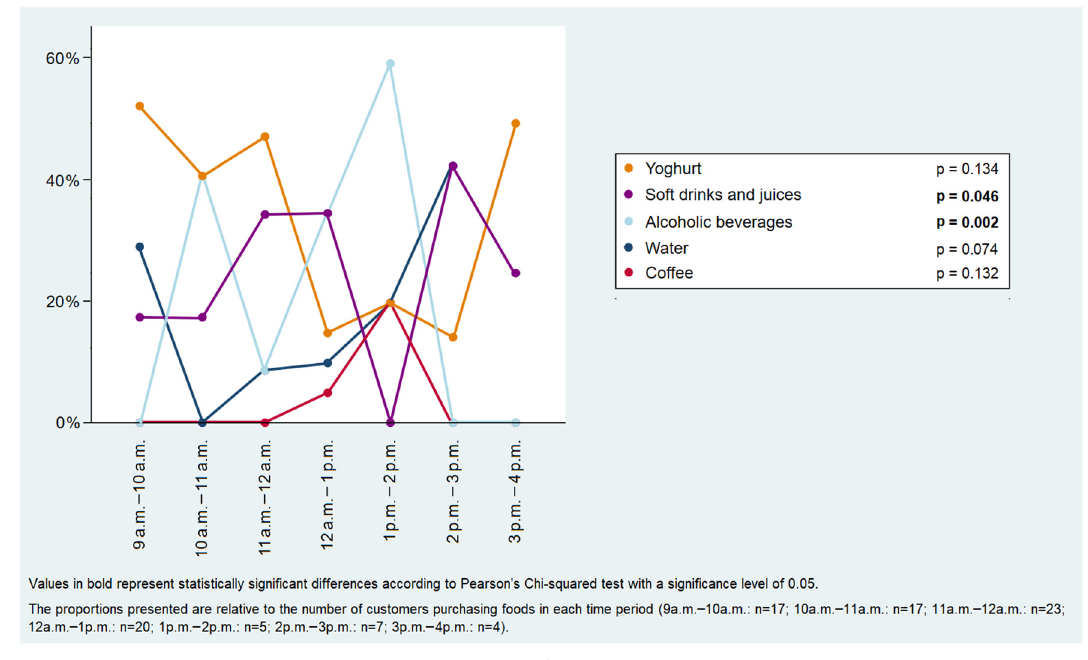
Figure 5. Distribution of the takeaway food purchases throughout the day: ( a ) foods (n = 434) and ( b ) beverages (n = 93).